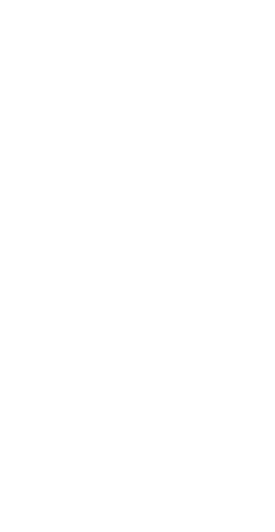
FIGURE 5 | Temporal development of D s ; dashed lines, fi tting curving by Eq.